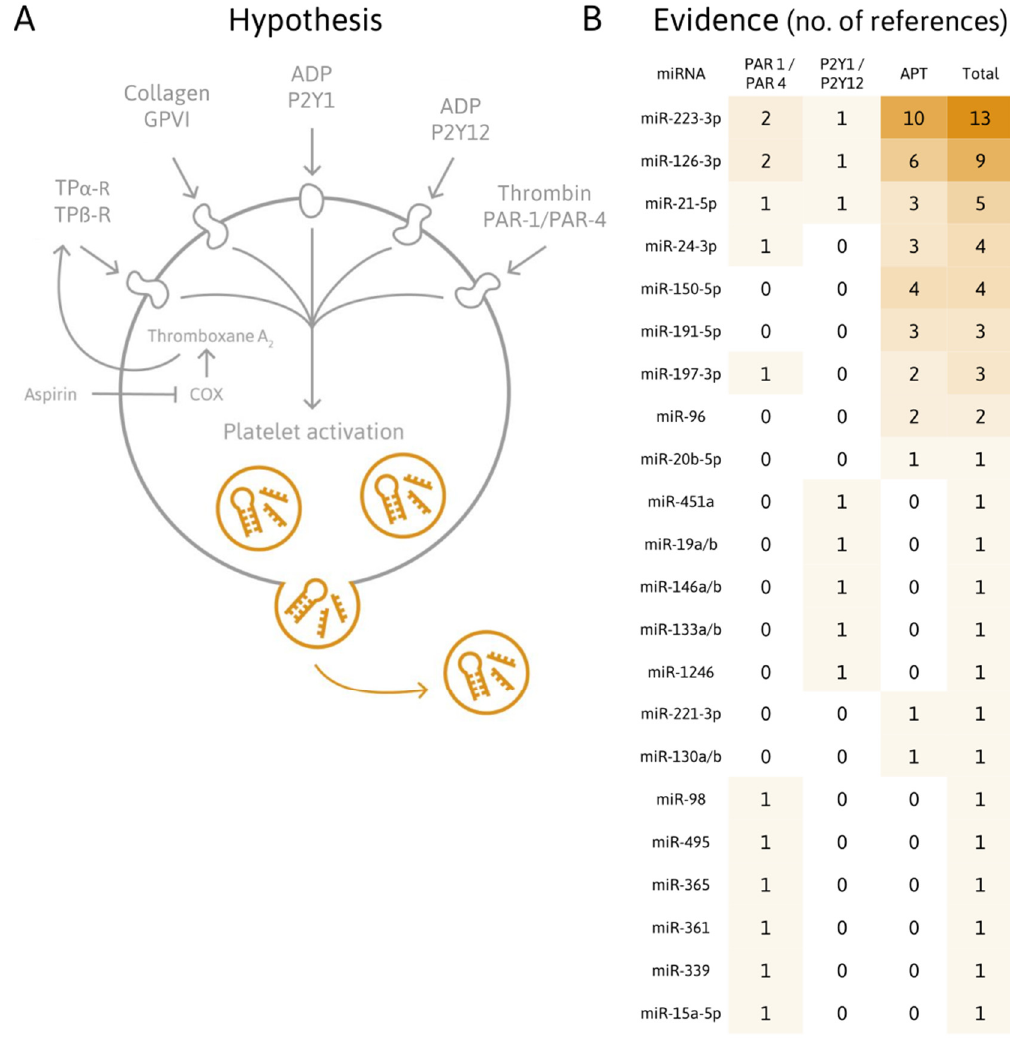
Figure 1. Do activated platelets secrete miRNAs? ( A ) Platelets release miRNAs upon activation by various agonists. Therefore, changes in plasma concentrations of platelet-derived miRNAs might inform on platelet activation and function and have clinical utility for monitoring antiplatelet therapy and cardiovascular diseases (CVDs). ( B ). Heatmap summarizing the number of studies cited in this review, which attempted to assess miRNAs in the context of platelet stimulation (through PAR 1/4 and P2Y1/P2Y12 receptors) and antiplatelet therapy, thus, providing evidence in support of this